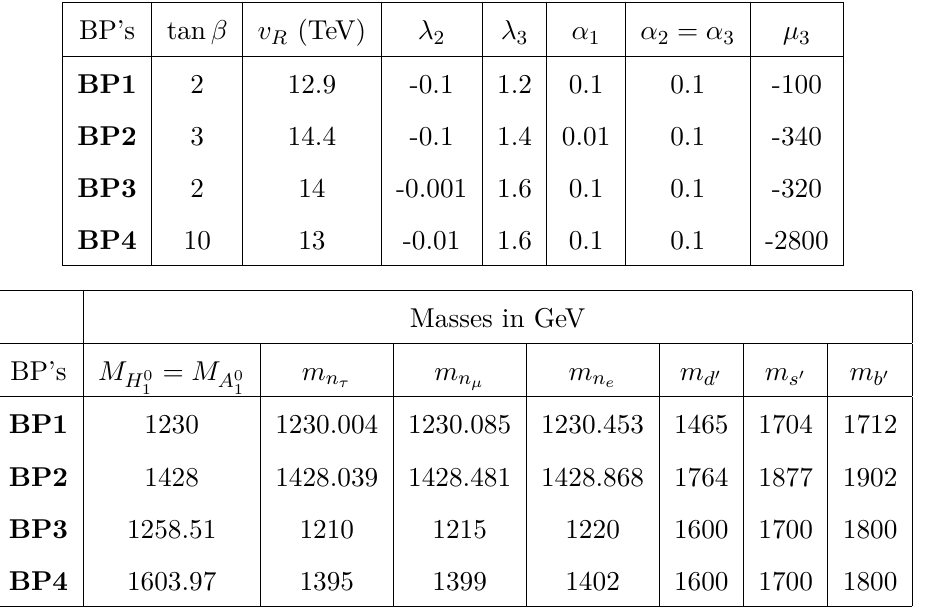
Table 6 . Benchmark points compatible with the scalar ( BP1 and BP2 ) and scotino ( BP3 and BP4 ) DM constraints, selected for the study of collider